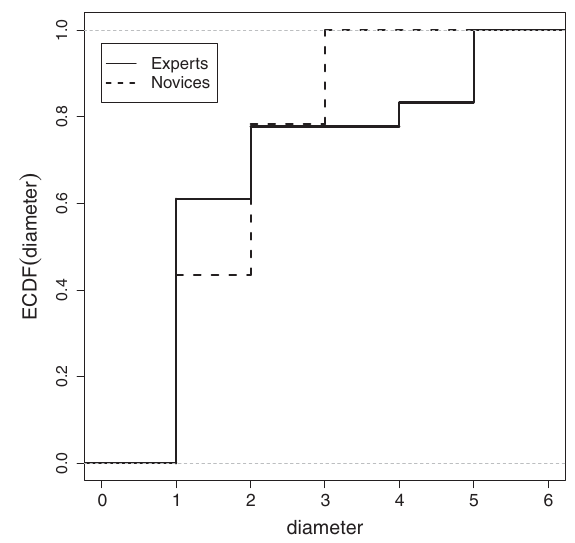
FIG. 6. Diameter. This is the distribution of the diameter of the experts and novices. A Kolmogorov-Smirnov test suggests that experts and novices are not distinguishable based on their diameter distributions ( p ¼ 0 : 6432 ).